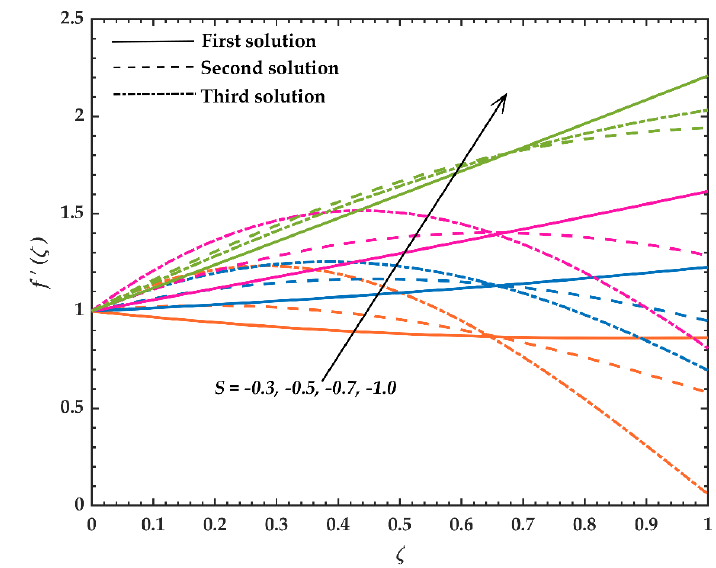
(cid:48) ( ζ ) when Pr = 30, We = 0.2, n = 0.6, M = 2 and σ = 1.2 as S Figure 6. Velocity profiles, as S varies. Figure 6. Velocity profiles, f